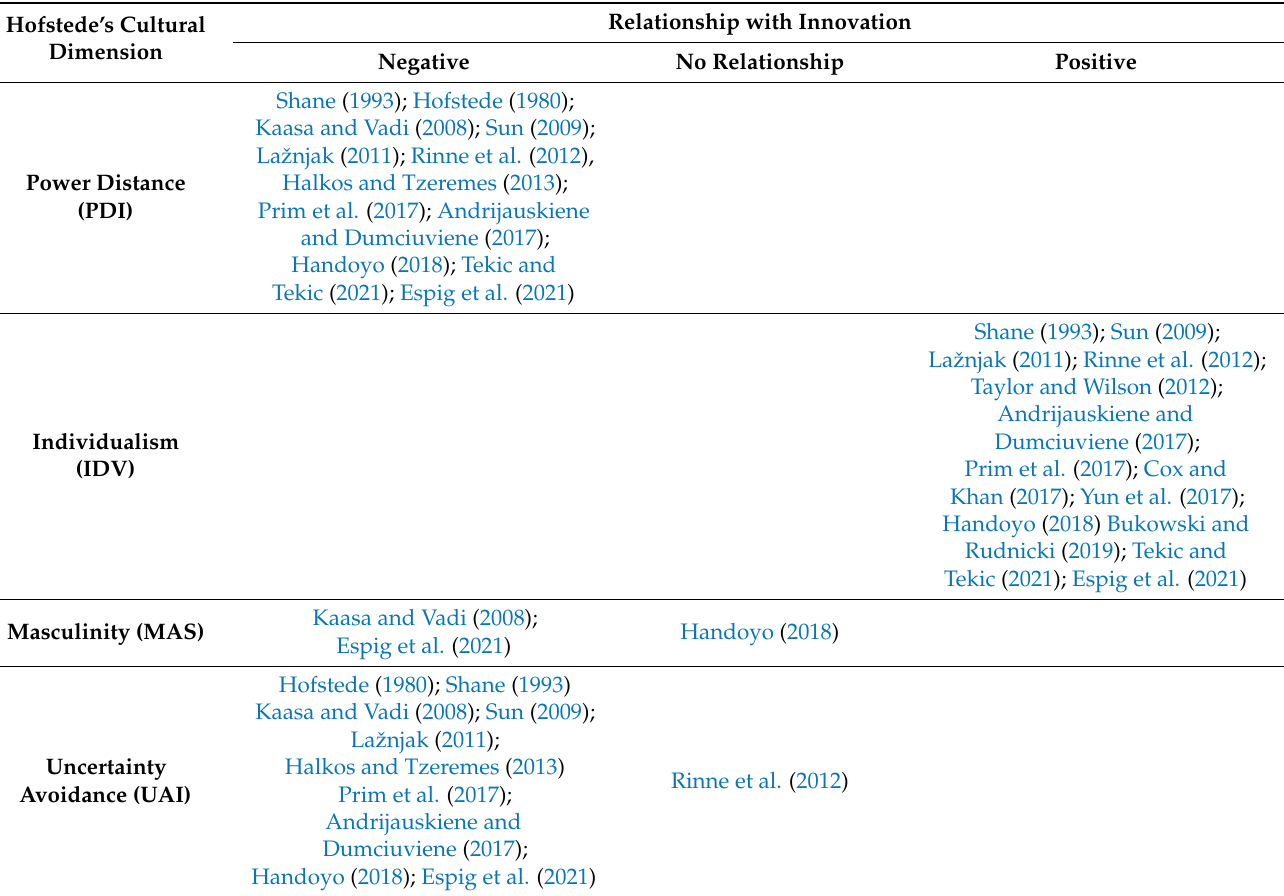
Table 2. The relationships between Hofstede’s cultural dimensions and the innovation performance of